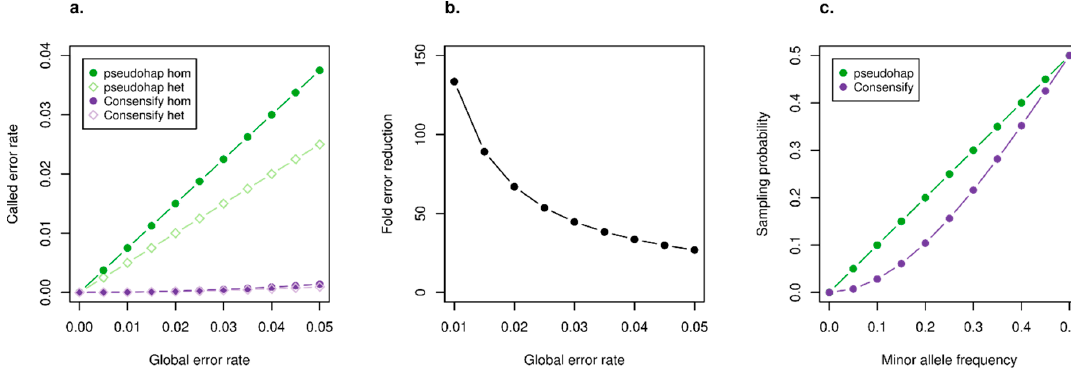
Figure 1. Expected performance of Consensify compared with standard pseudohaploidisation, assuming equal base composition and equal error probabilities across all nucleotides. ( a ) Shows the expected called error rates (y axis) across a range of global error rates (x axis) for standard pseudohaploidisation (green) and Consensify (purple), for both homozygous sites (circles) and heterozygous sites (rhombuses). ( b ) Shows the fold-reduction in error rates achieved by using Consensify compared with pseudohaploidisation (y axis), for a range of global error rates (x axis). Note that the fold-reduction in error is equal for both homozygous and heterozygous sites. ( c ) Shows the probability of sampling (y axis) an allele which is underrepresented in the read stack (x axis) using Consensify and standard pseudohaploidisation.